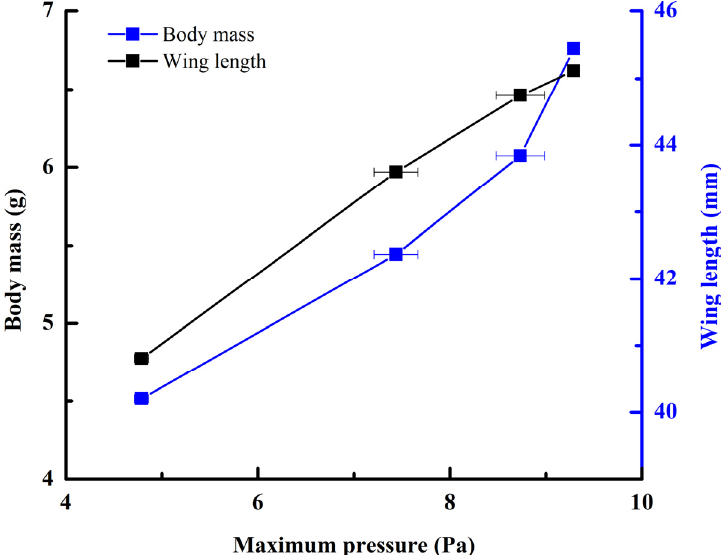
Figure 3. Pressure is proportional to the length of wings and the body mass.